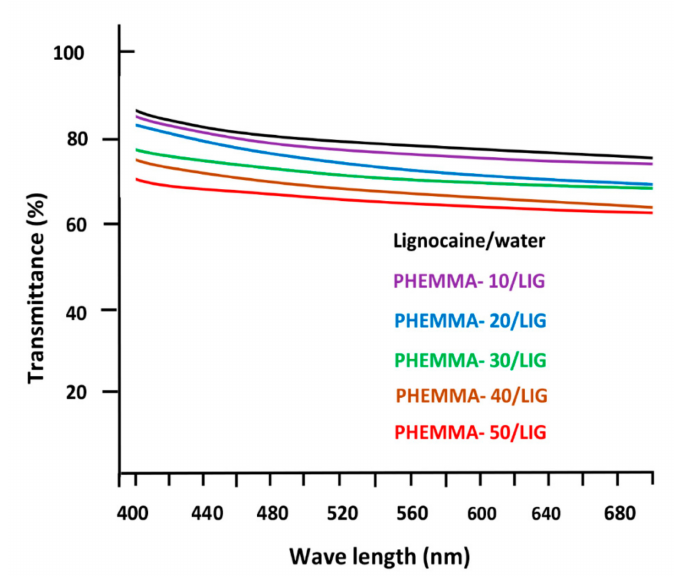
Figure 9. Spectra of the wet PHEMMAC / LIG with di ff erent MMA contents: ( A ) LIG / water; 13.26 mol %; ( B ) 22.18 mol %; ( C ) 33.21 mol %; ( D ) 48.56 mol %; and ( E ) 63.32 mol % recorded in the visible light domain (400–700 nm).